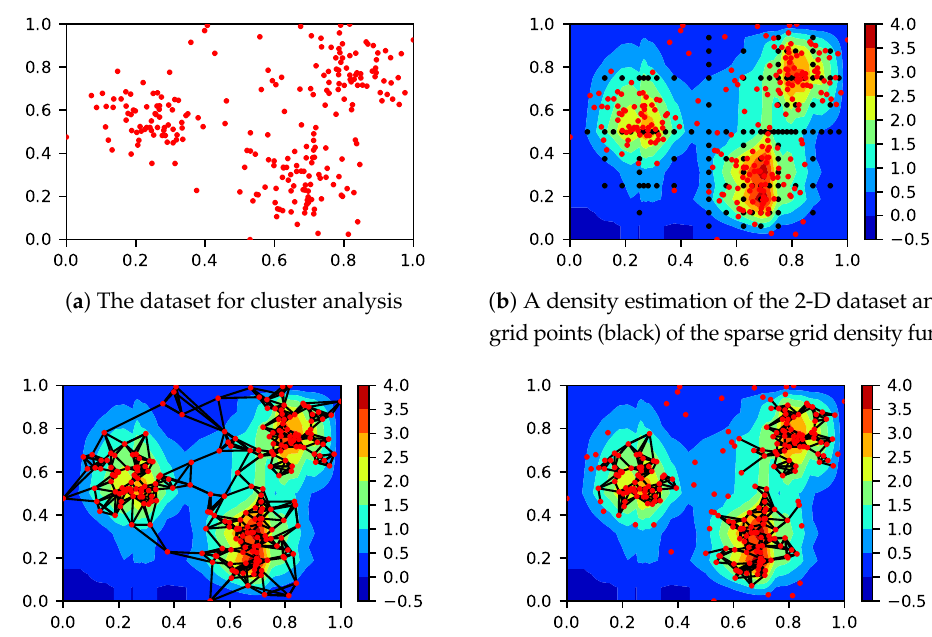
Figure 1. The application of the sparse grid clustering algorithm to a 2-D dataset with three slightly overlapping clusters. After calculating the sparse grid density estimation and the k -nearest-neighbor graph, the graph is pruned using the density estimation. This splits the graph into three connected